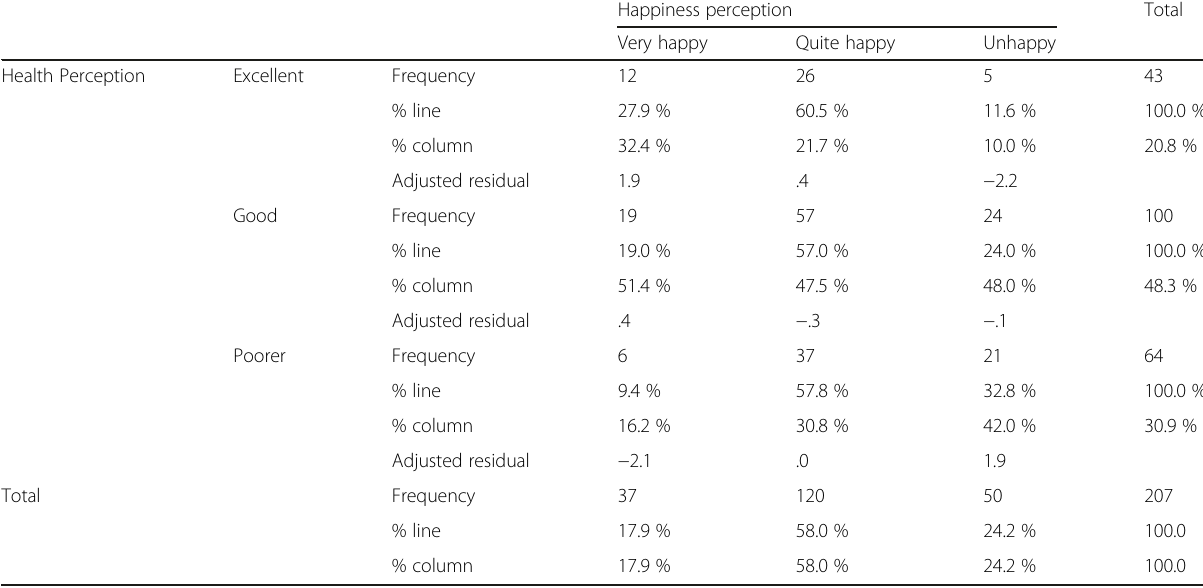
Table 2 Comparison between health perception variable and happiness perception variable on disable